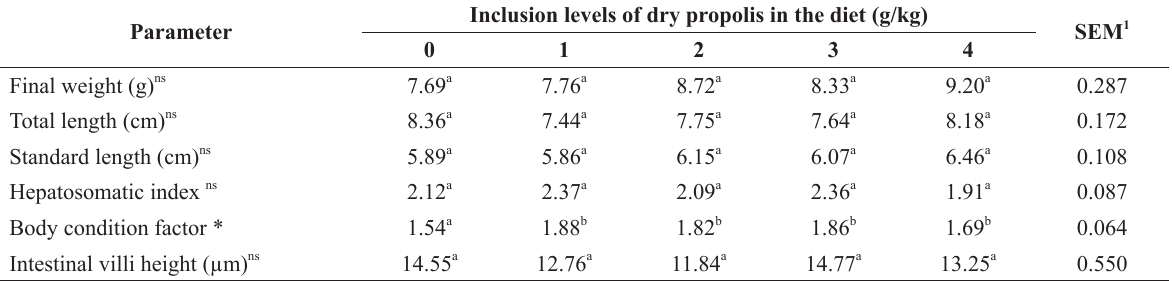
Parameters of production performance and intestinal villi height of Nile tilapia fingerlings fed with increasing levels of alcoholic extract of propolis in the diet. Inclusion levels of dry propolis in the diet (g/kg) Parameter